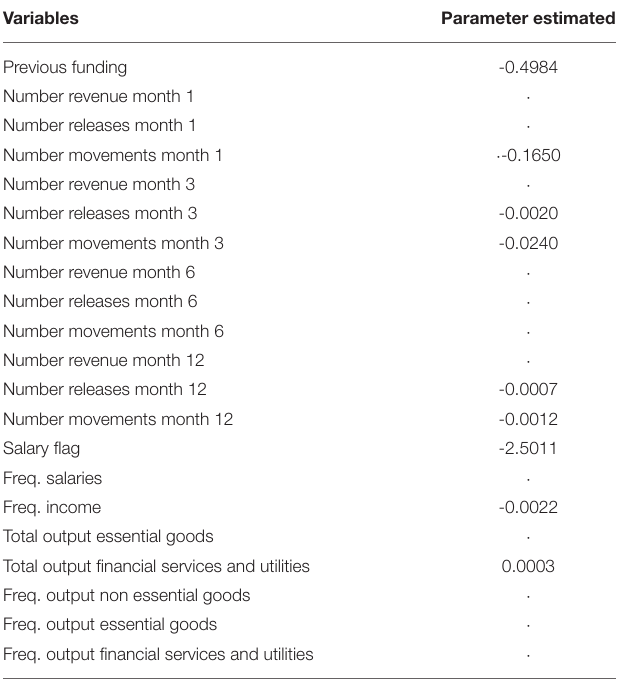
TABLE 5 | Important variables selected by Lasso Model on mixed dataset.